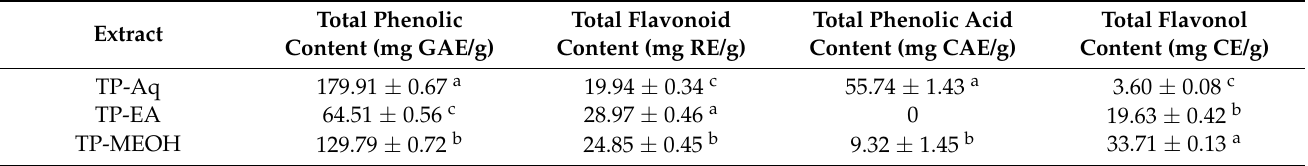
Table 1. Phytochemical profile of the